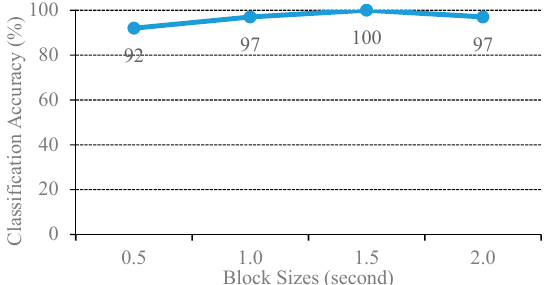
Figure 5. Classification performance of the original and combination source MSVM with various block sizes.